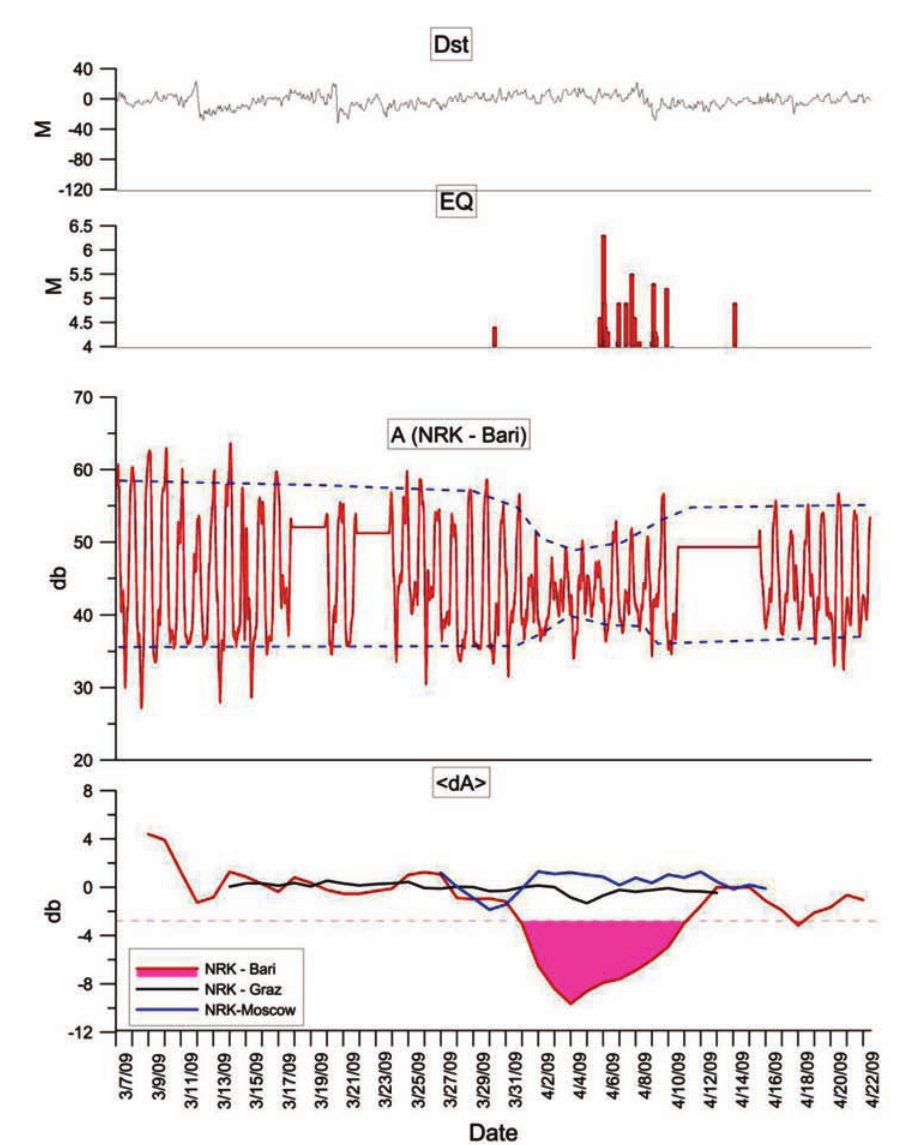
Figure 1. Variations in the amplitudes of the LF signals in NRK-Bari wave path during the period of the earthquake in L’Aquila. Upper panels: Dst index of geomagnetic activity and magnitudes of the main earthquakes between March 30 and April 9, 2009. Middle panel: Signal amplitudes (A) of the NRK signals recorded at Bari in the period March 7 to April 22, 2009. Bottom panel: Night-time residual amplitude (dA) for the NRK-Bari, NRK-Moscow and NRK-Graz paths. Colored region, period in which the residual amplitude exceeded the 2(cid:0) level (horizontal dotted line) for the NRK-Bari